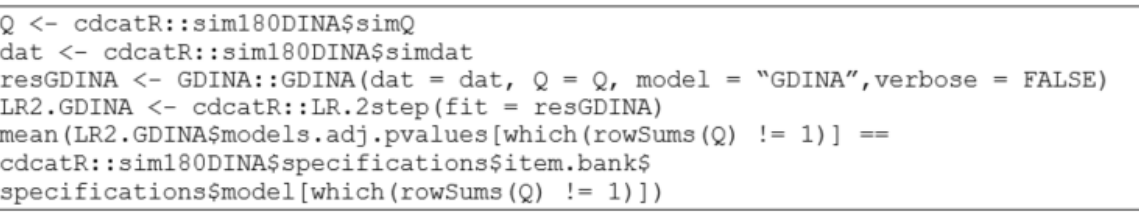
Figure 4. Illustration of how the LR.2step() function can be used to perform item-level model comparison analysis.